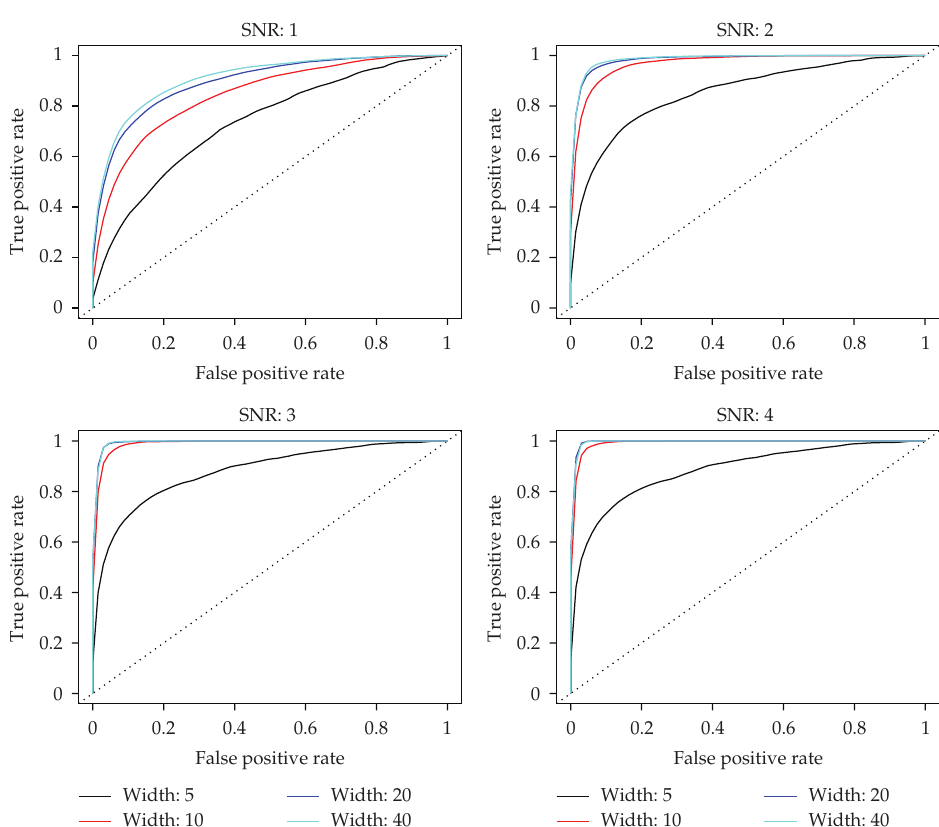
Figure 4: Receiver-operating characteristic curves showing the performance of our CNA-calling algorithm on the simulated data (cid:4) 13 (cid:5) . Each panel represents a di ff erent signal-to-noise ratio and the curves represent varying event widths of the simulated data. The x -axis represents the false positive rate, and the y -axis represents the true positive rate. Each curve is generated by testing varying thresholds on 100 simulated chromosomes for the condition specified. The curves are combined using vertical averaging. The dashed line represents the random